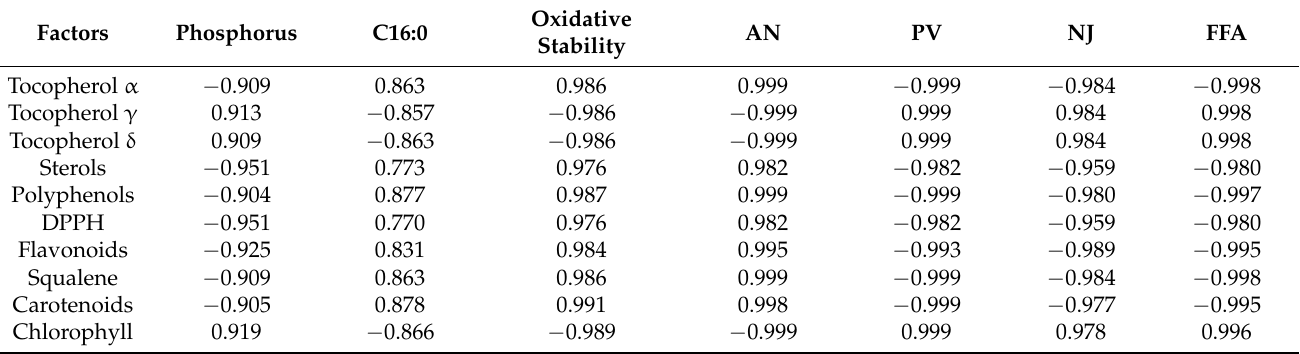
Table 8. Results of Pearson’s linear correlation coefficient analysis at the p < 0.05 significance